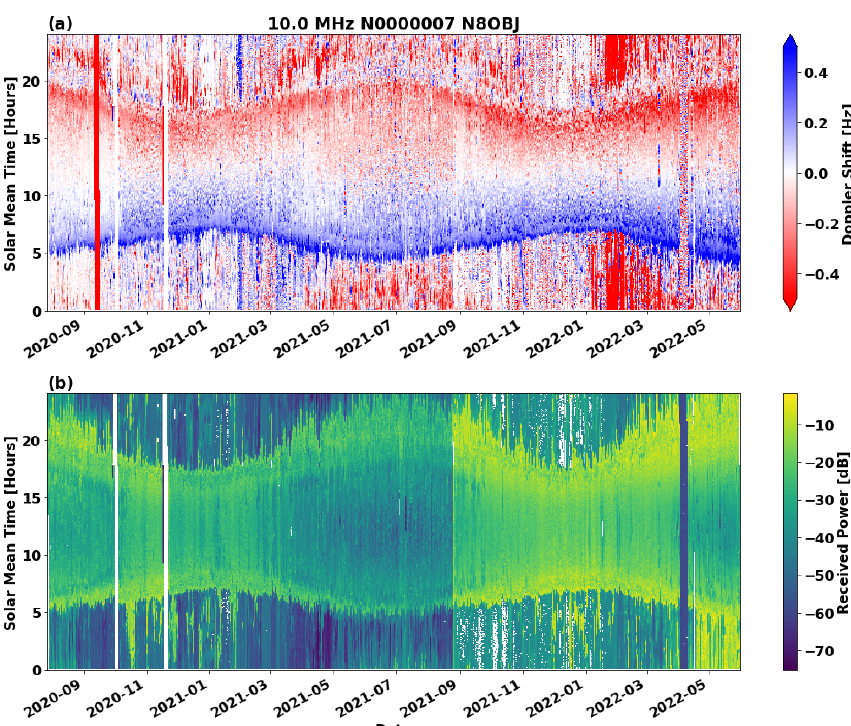
Figure 6. Heat maps of frequency (a) and amplitude (b) at Node 7. Each day represents a line of pixels from top to bottom, with correspond- ing UTC times lined up across the plots horizontally. Diel variation, and the seasonal shift of sunrise and sunset times per Fig. 7, is clearly visible in both plots. A new antenna and preamplifier were installed on 26 August 2021, resulting in higher received power.